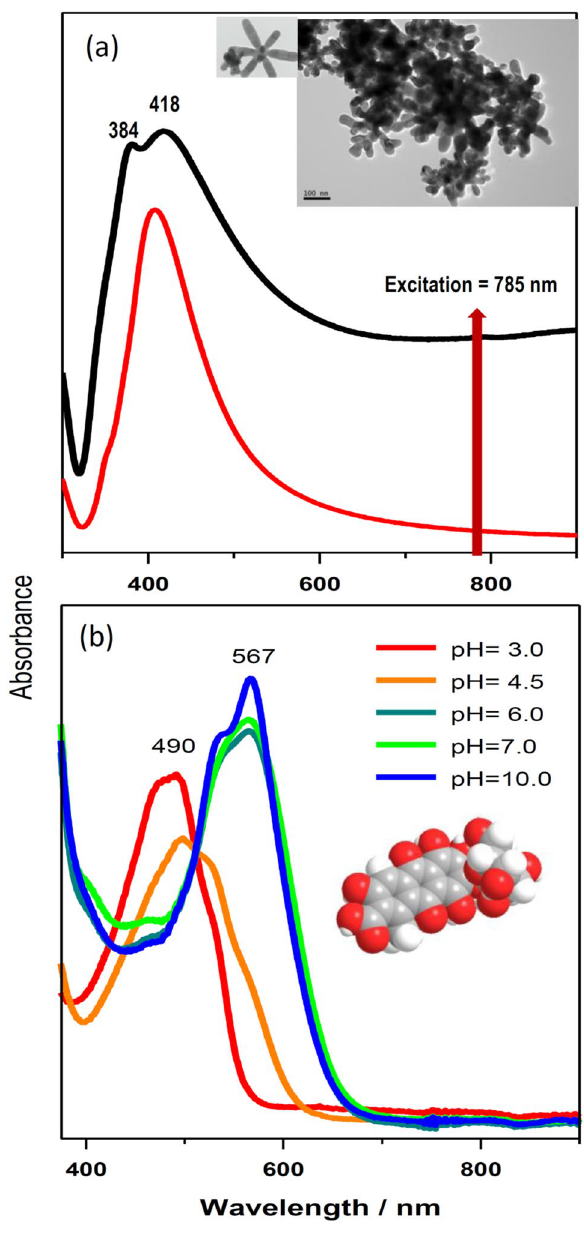
Figure 3. Extinction spectra of Ag nanostars (black) and AgNP obtained by reduction with citrate (red) ( a ). Inserted image: TEM images of Ag nanostars. UV–visible spectra of carminic acid and carminate at different pH (2 × 10 –5 M) ( b